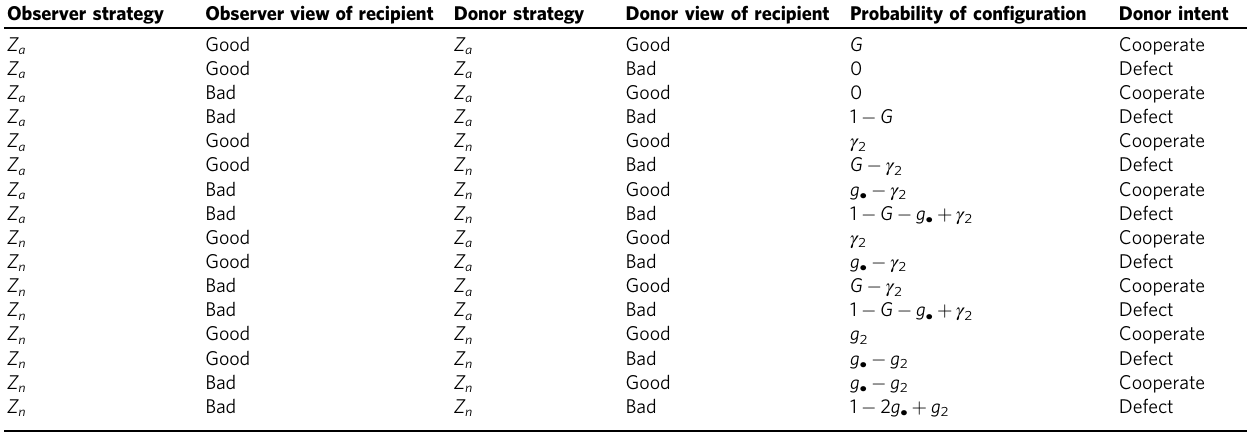
Table 2 Possible con fi gurations of an observer, donor, and